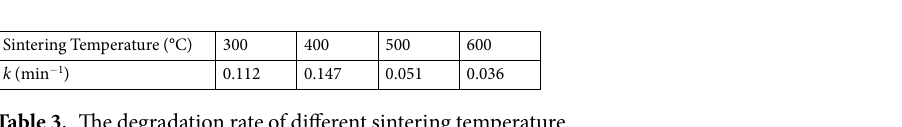
Table 3. The degradation rate of different sintering